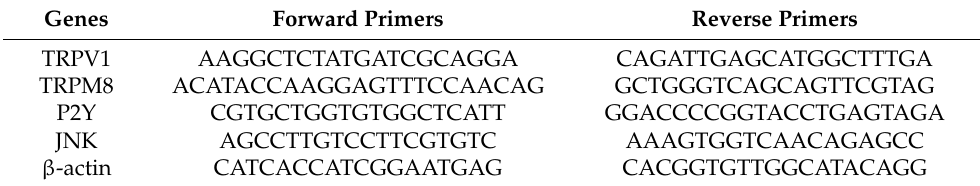
Table 2. The sequences of the forward and reverse